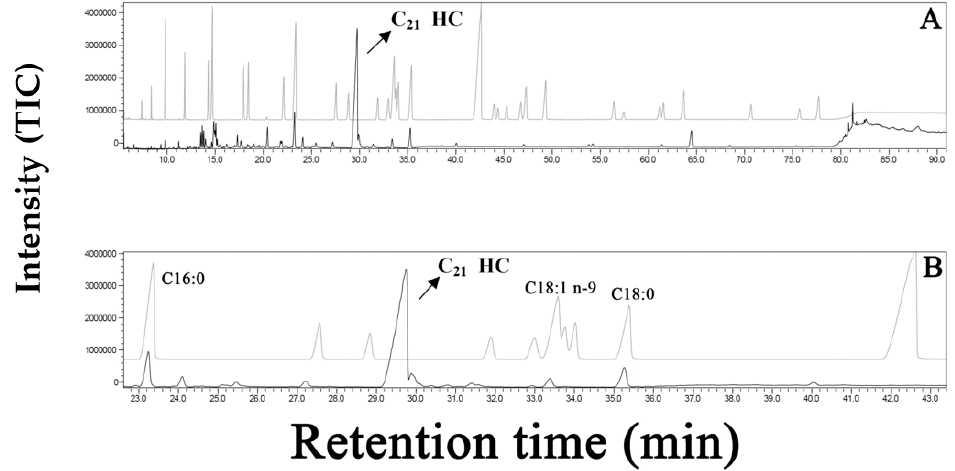
Figure 6. Chromatograms (CG/MS) of the fraction FA3 from P. gymnospora in ( A ) Low magnification; ( B ) Higher magnification. The chromatogram of the major compound 5 Z ,8 Z ,11 Z ,14 Z -heneicosatetraene (C21:4 HC, ( B )) was superimposed with a FAs standards chromatogram obtained in the same conditions [( B ) C16:0 = palmitic acid, C18:1 ( n -9) = oleic acid, and C18:0 = stearic acid]. TIC = total ion chromatogram.